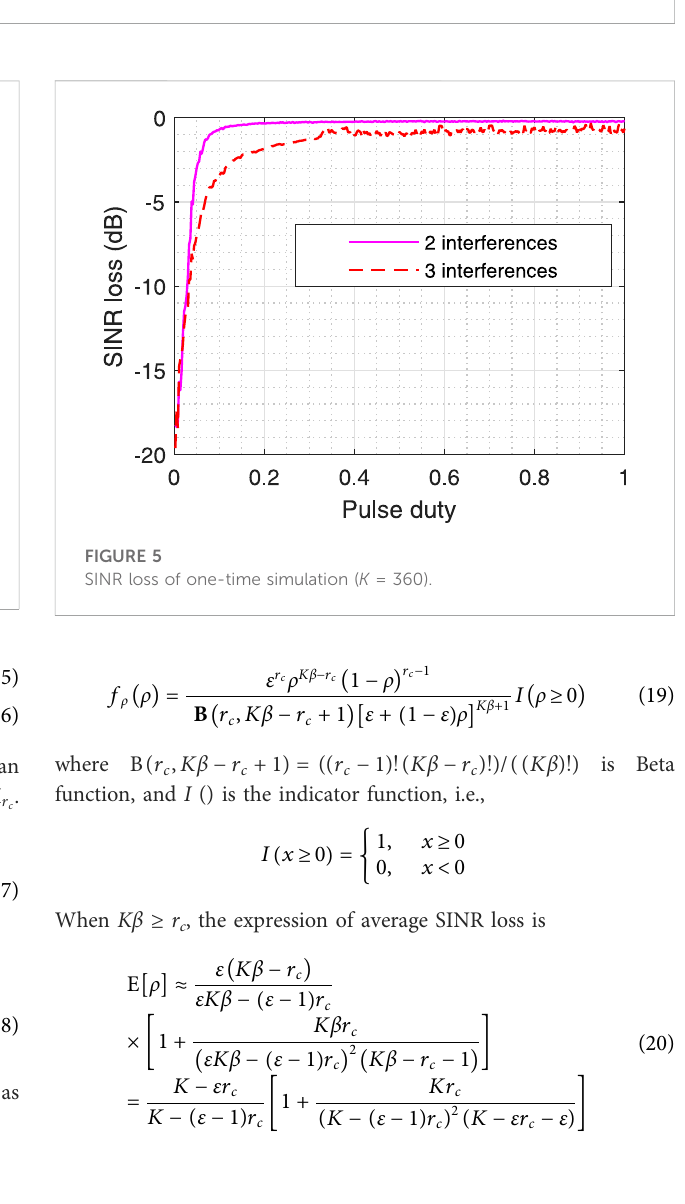
FIGURE 3 Block diagram of array signals simulation in pulse interference environment.